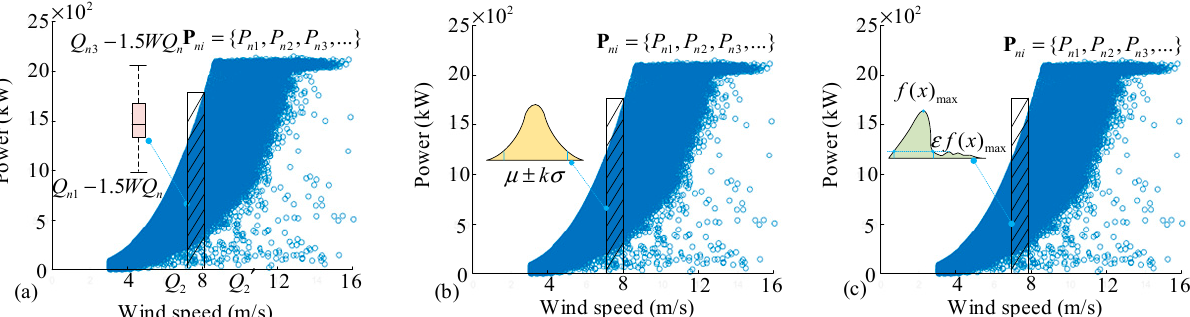
Figure 5. Preliminary data filtering principle. ( a ) Quartile method; ( b ) PauTa criterion; ( c ) KDE method.